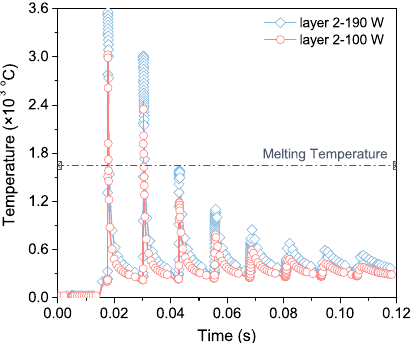
Figure 6. Temperature evolution at the center of the 2nd layer under different power